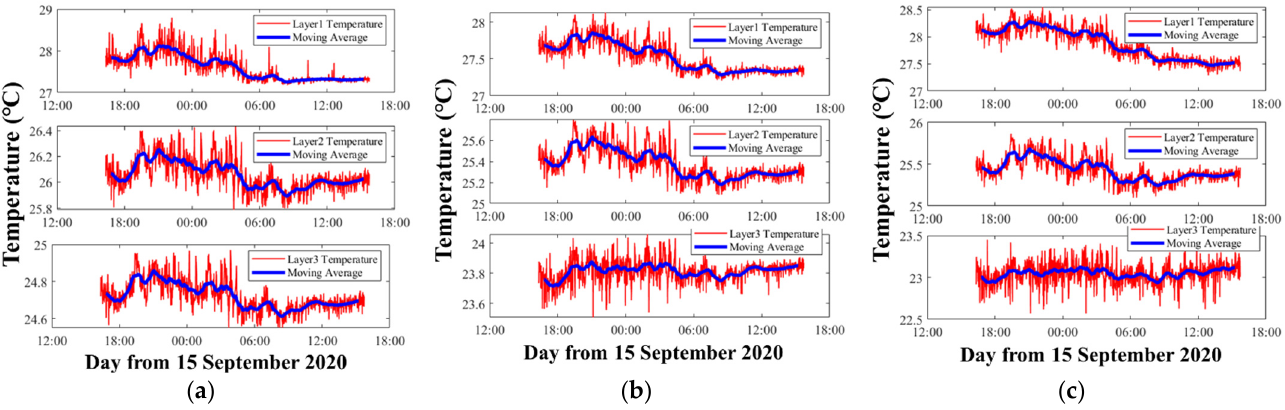
Figure 6. Average temperatures of three layers along a vertical slice. ( a ) Layer division results of Number 3 ‐ 5. The pvtem ‐ er wa smaller than 0.8 °C . ( b ) Layer division results of Number 3 ‐ 7. The pvtem ‐ er was smaller than 0.8 °C . ( c ) Layer division results of Number 3 ‐ 7. The pvtem ‐ er was smaller than 0.05 °C . The red curve indicates the layer average temperatures, the blue bold curve indicates 1 h moving average of the data.